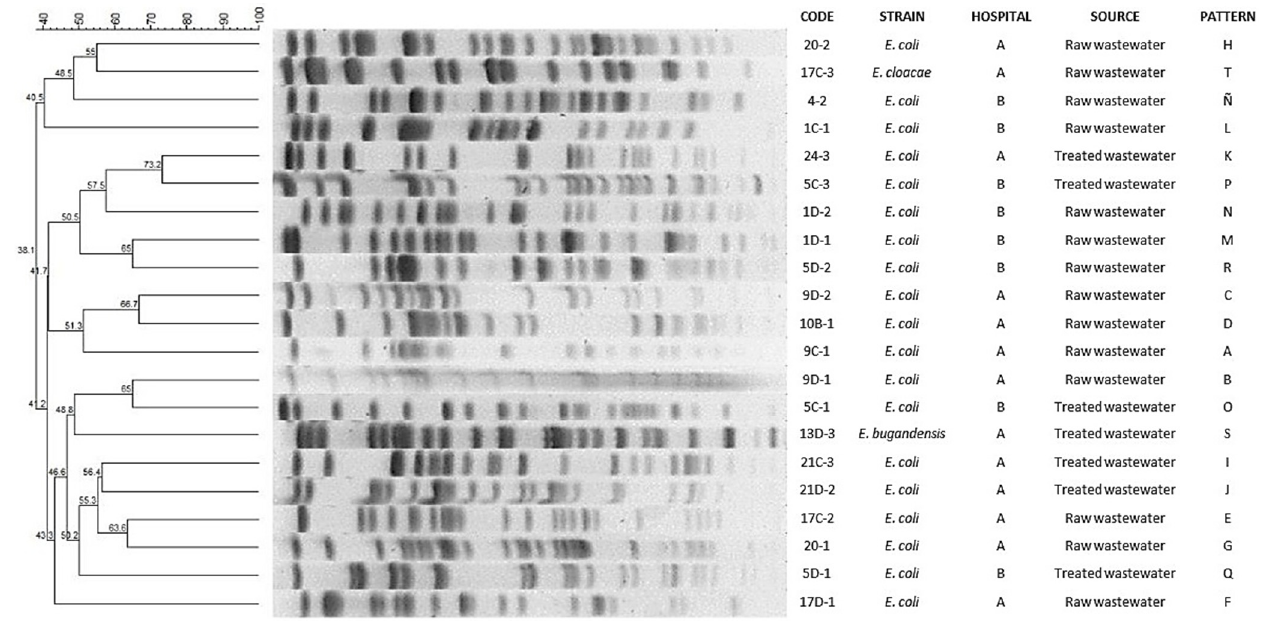
Figure 1. Dendrogram based on pulsed-field gel electrophoresis (PFGE) patterns after digestion with enzyme Xba I of E. coli and Enterobacter spp. isolates isolated from hospital wastewater.